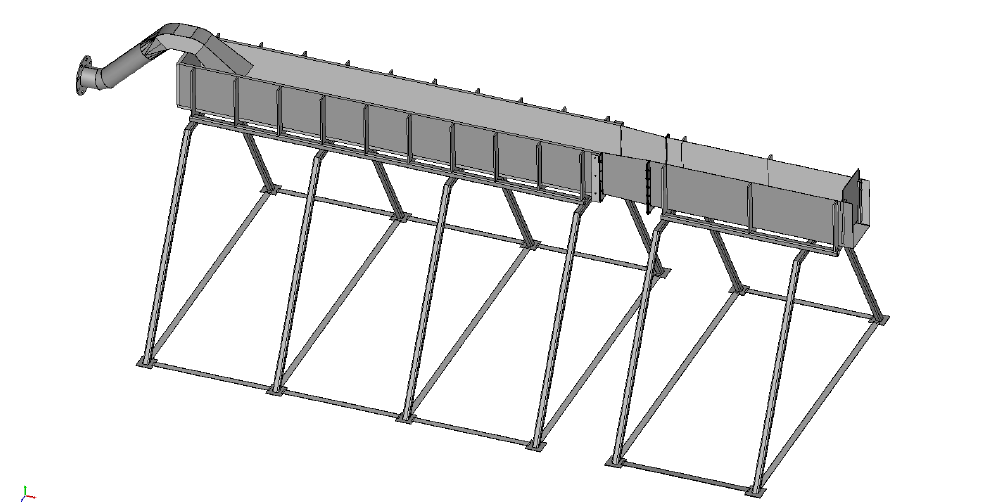
Figure 1. Test channel with the inlet